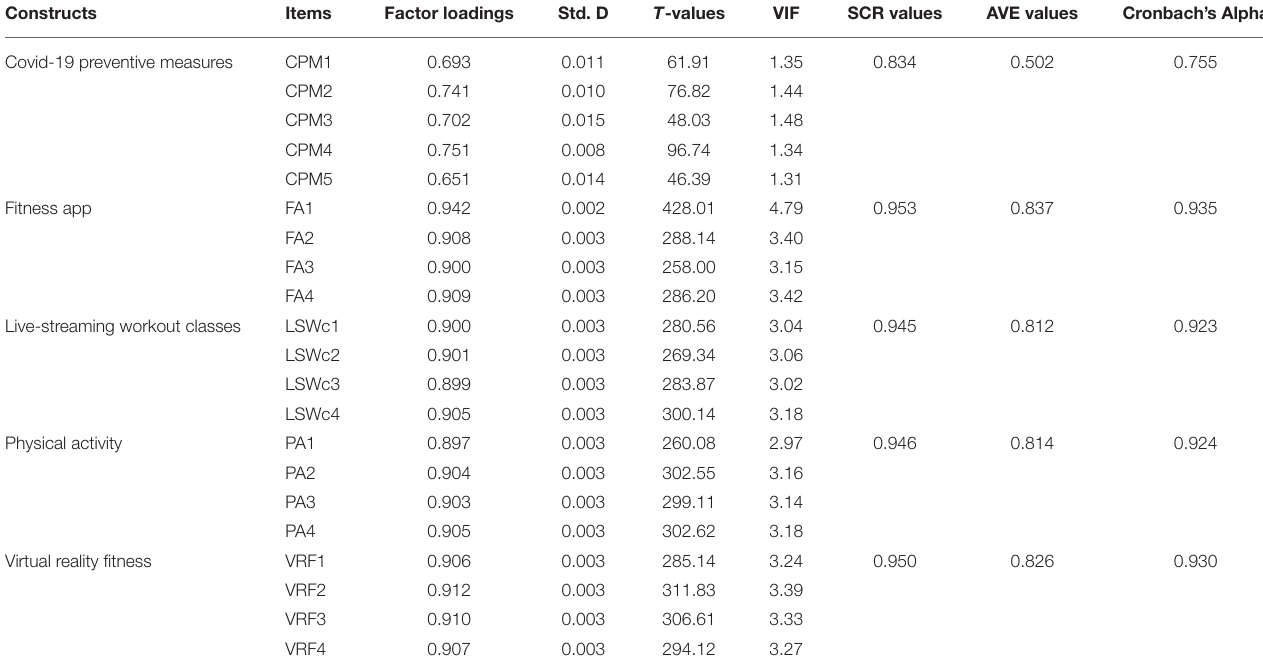
TABLE 3 | Results for measurement of the conceptual framework ( N -5,351). Constructs